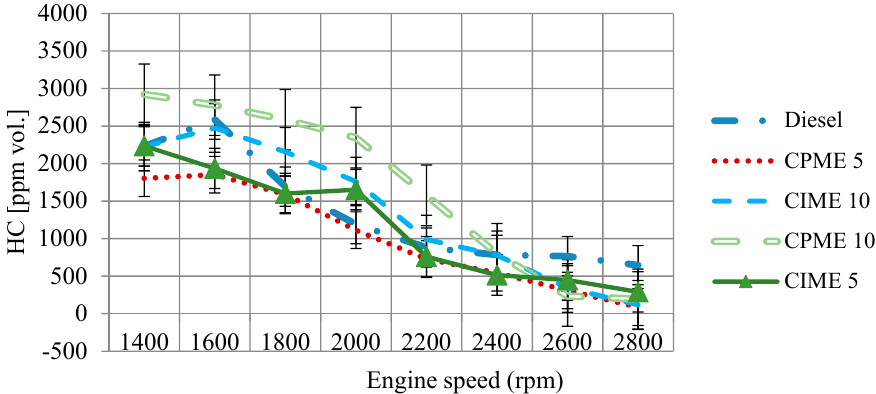
Figure 5. Changes in Hydrocarbon (HC) emissions of diesel, CPME, and CIME blends with speeds.